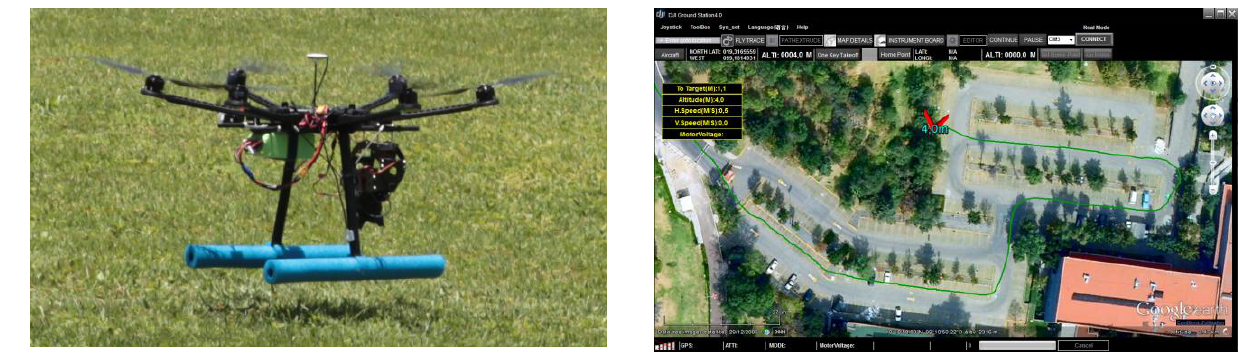
Figure 2. Ground Station software interface